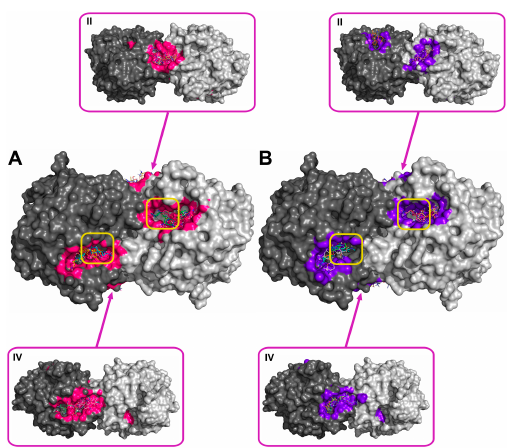
Figure 3. Supposed localization of the domains for binding gentamicin at pH 7.5 ( A ) and 10.5 ( B ). The two subunits of the His 6 ‐ OPH homodimer are colored differently (grey and dark grey). Atoms on the surface of His 6 ‐ OPH located within 4 Å of any atom of gentamicin, as well as the corresponding molecular surface, are colored pink ( A ) or purple ( B ). Entrances to the active sites of the His 6 ‐ OPH dimer are highlighted with yellow boxes. Magenta boxes show clockwise a His 6 -OPH dimer molecule when it is viewed from above (II) and below (IV) (relative to the side where the active sites are